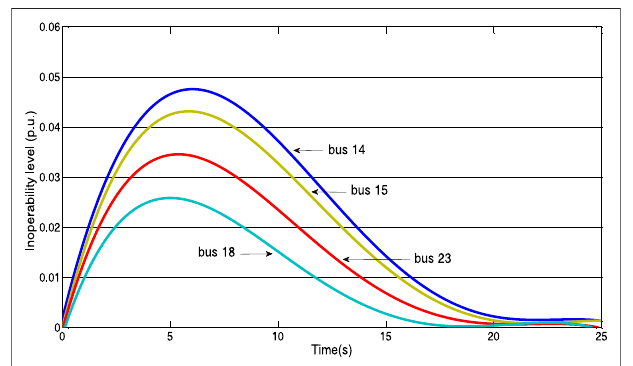
FIGURE 7 | Inoperability changes after control measures are